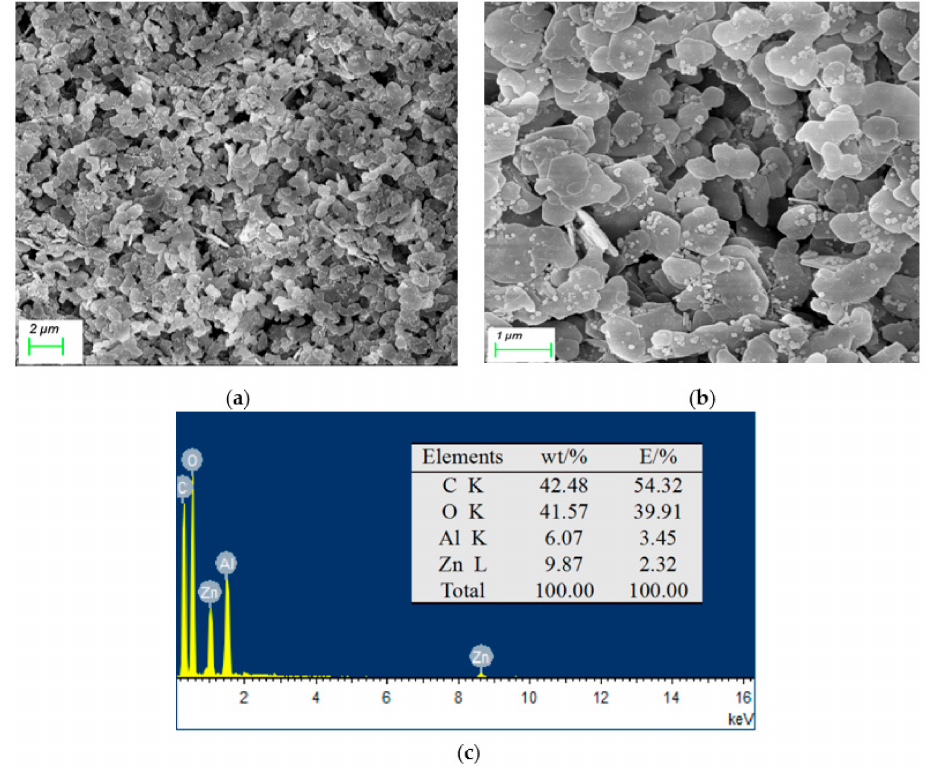
Figure 5. SEM images ( a ) 2.5 kx, ( b ) 10.0 kx, and EDS analysis ( c ) of Zn 2+ -Al 3+ -C 4 H 4 O 6 2 −